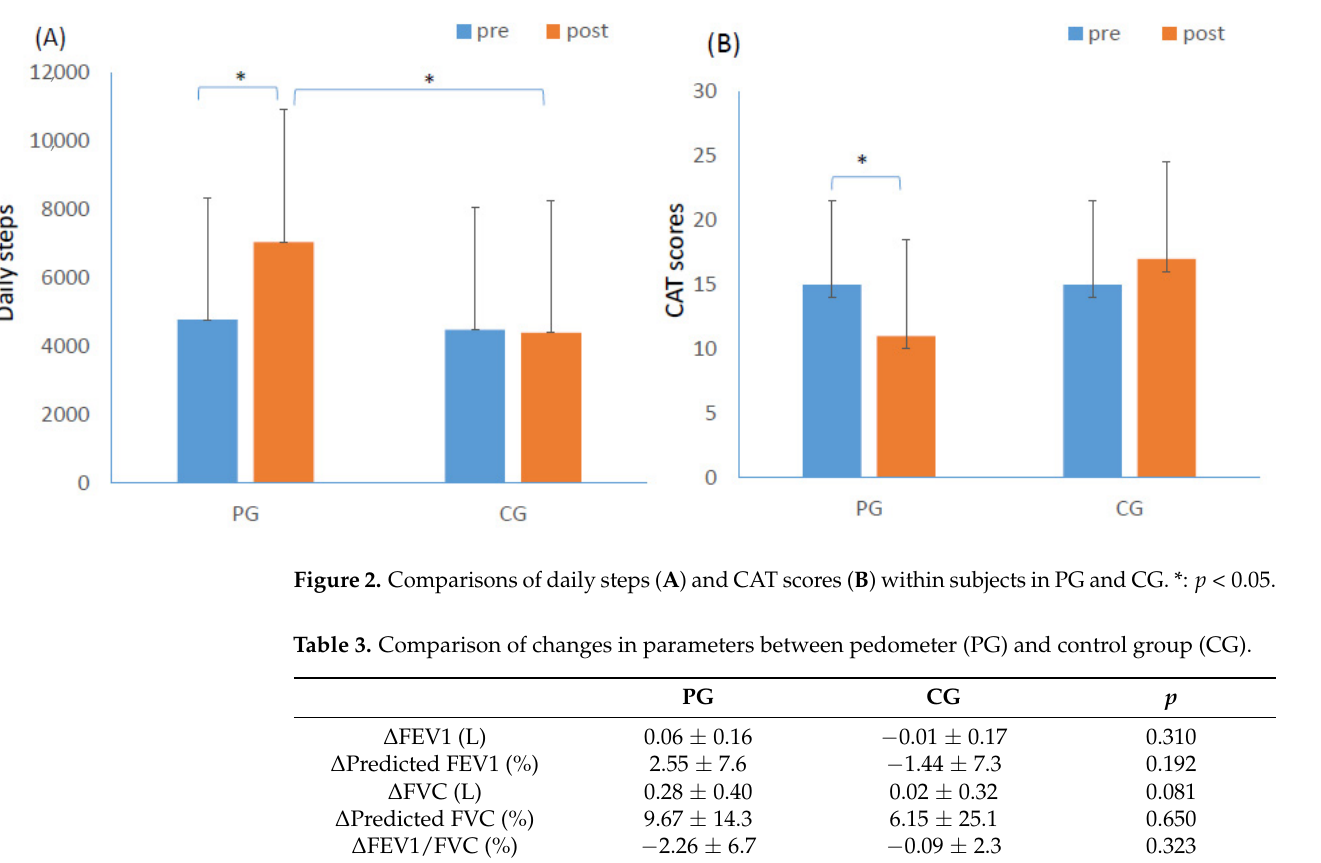
Table 3. Comparison of changes in parameters between pedometer (PG) and control group (CG).